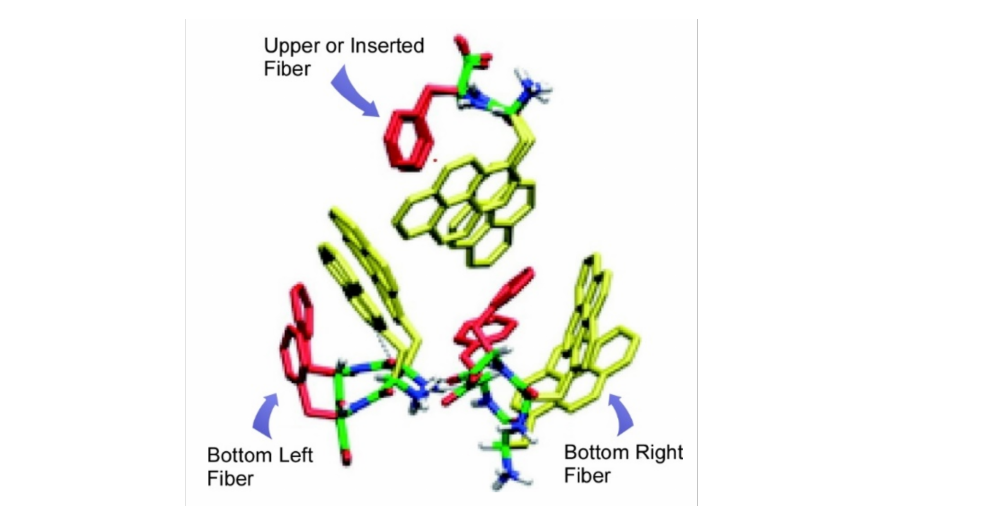
Figure 17. Pyrene–pyrene interactions between two D-pyrenylalanine-L-phenylalanine dipeptide fibers as suggested by molecular simulation. Reprinted with permission from Reference